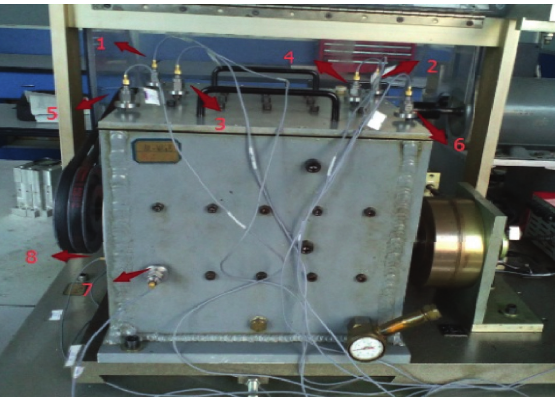
Figure 16: Sensor distribution.